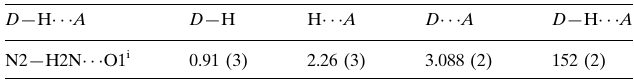
Hydrogen-bond geometry (A˚ , (cid:1)